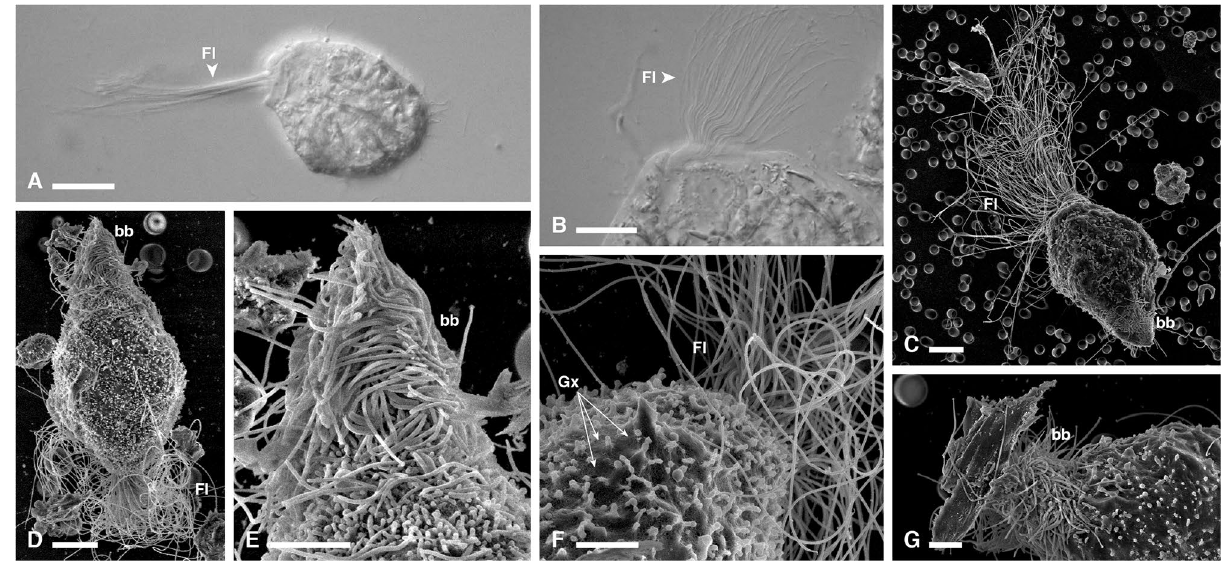
Figure 4. Light and electron micrographs of R. pacha specimens. ( A , B ) DIC and ( C – G ) SEM images of Runanympha pacha specimens from Comatermes perfectus showing the overall body shape, with flagella, tufts of surface bacteria on the posterior tip of the cell surface, axostyle, and glycocalyx. Fl flagella, bb bacteria, Ax axostyle, Gx